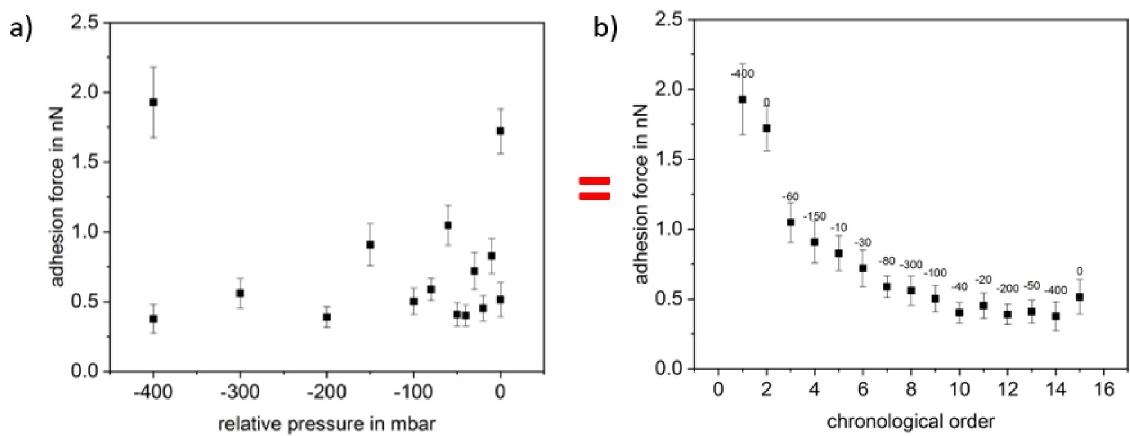
Fig 6. Adhesion force of Paracoccus seriniphilus on glass in a FluidFM experiment. Both, a and b, show the same data set, either sorted according to the applied pressure (a) or in chronological order (b); each data point comprises 25 force-distance curves.